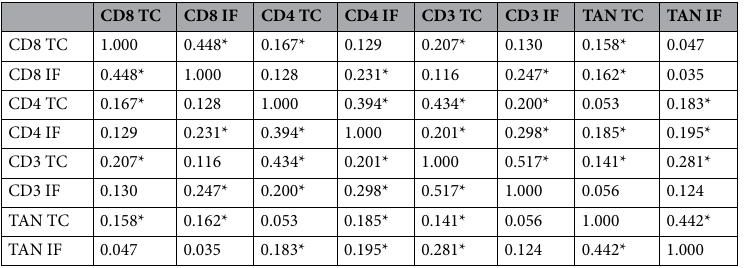
Table 6. Spearman’s rank correlation coefficients between selected tumor-infiltrating immune cells. Marked correlation coefficients are significant with p < 0.05.